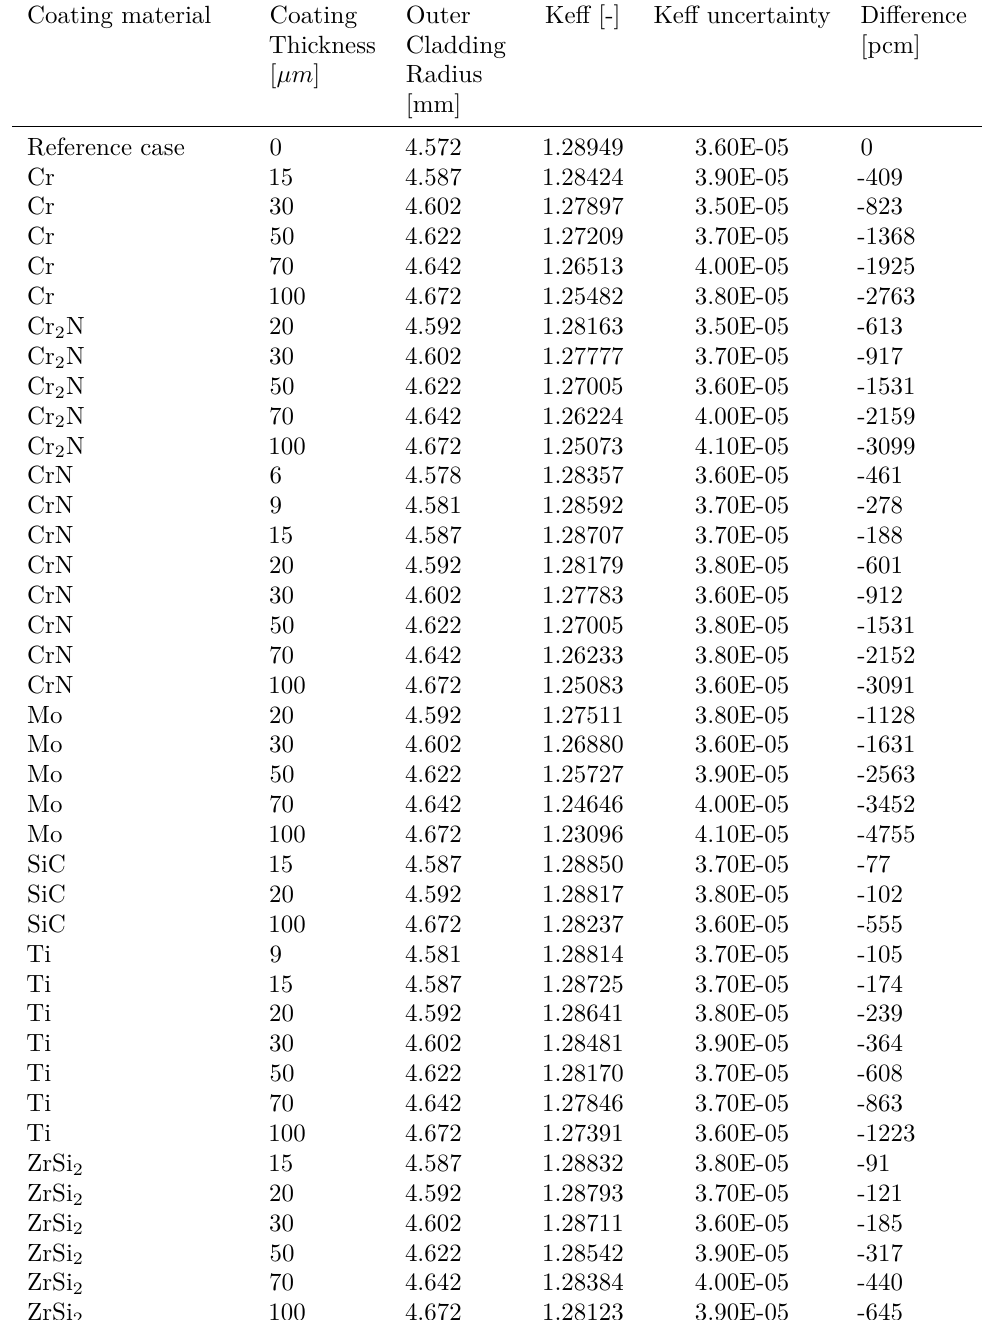
Table 6. Multiplication factors for different coating materials and